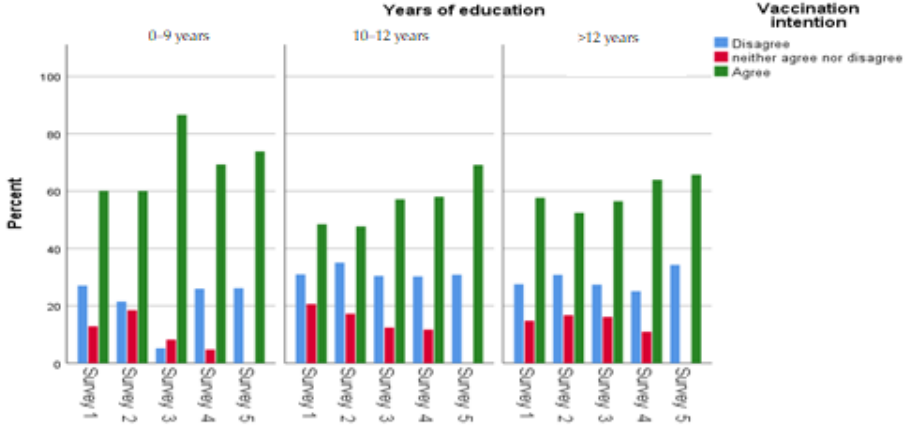
Figure 4. Age groups and vaccination intention across the surveys.